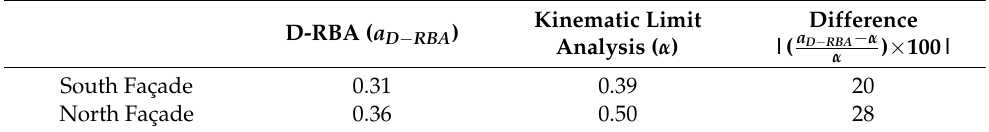
Figure 10. DEM-guided macro-block representation of South ( left ) and North ( right ) façades. Table 3. Comparison of D-RBA and Kinematic Limit Analysis (acceleration